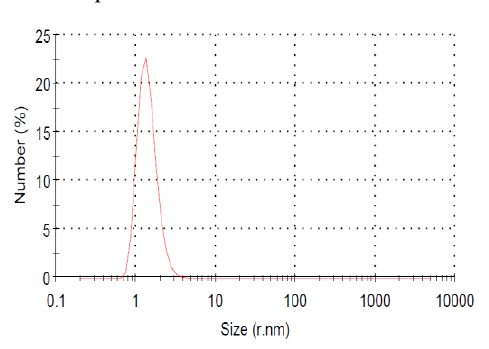
Fig. 1. FTIR spectrum of PPI dendrimer